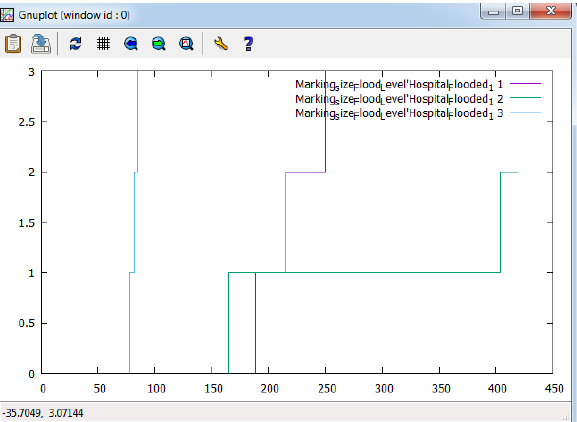
Figure 8. Number of Tokens Present in the Healthcare CI